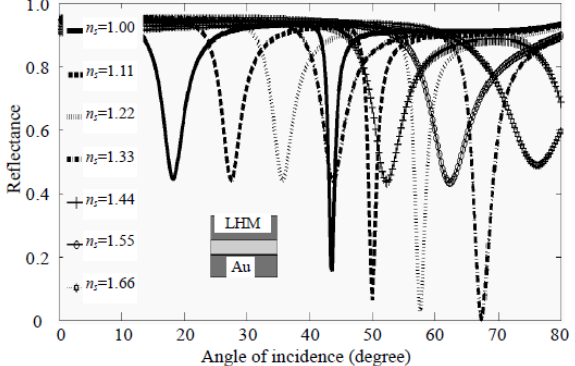
Fig. 2 Simulated SPR curves with different refractive indexes of sensing layer (thickness 385 nm) stacked between Au the layer (refractive index ε Au = –21.3 + 1.34i thickness 40 nm ) and left-handed materials (LHM) of {  LHM ,  LHM } = {–33.5, –11}.